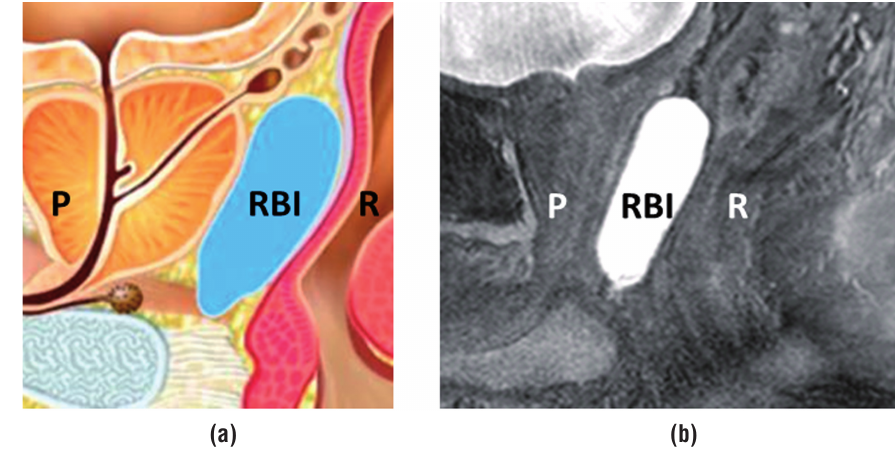
figure 1 - A schematic illustration (www.bioprotect.co.il) (a) and an MRI image (Balanced fast field Echo- sequence) (b) of a biodegradable rectum balloon implant (RBI) between the anterior rectum wall (R) and the prostate (p), creating space between the two organs.